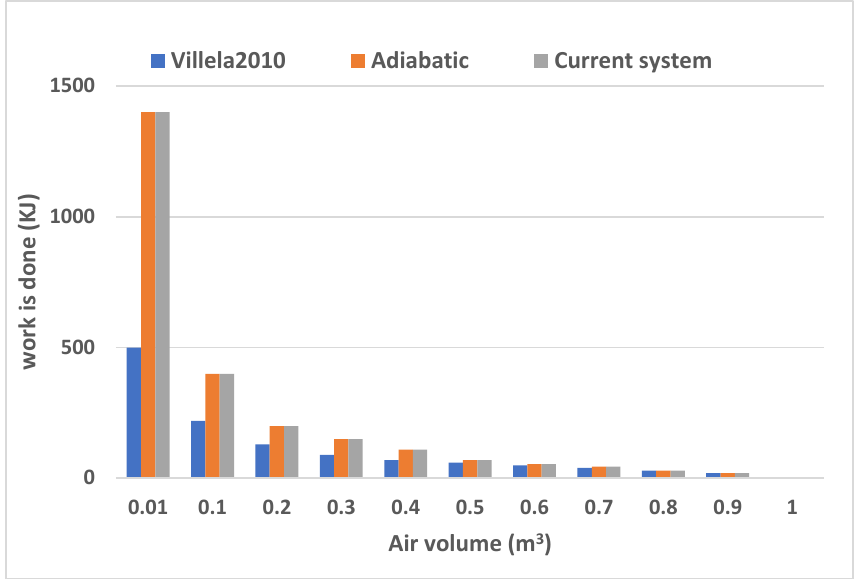
Figure 4. Changes in the conducted work compared to the air volume inside the tank.